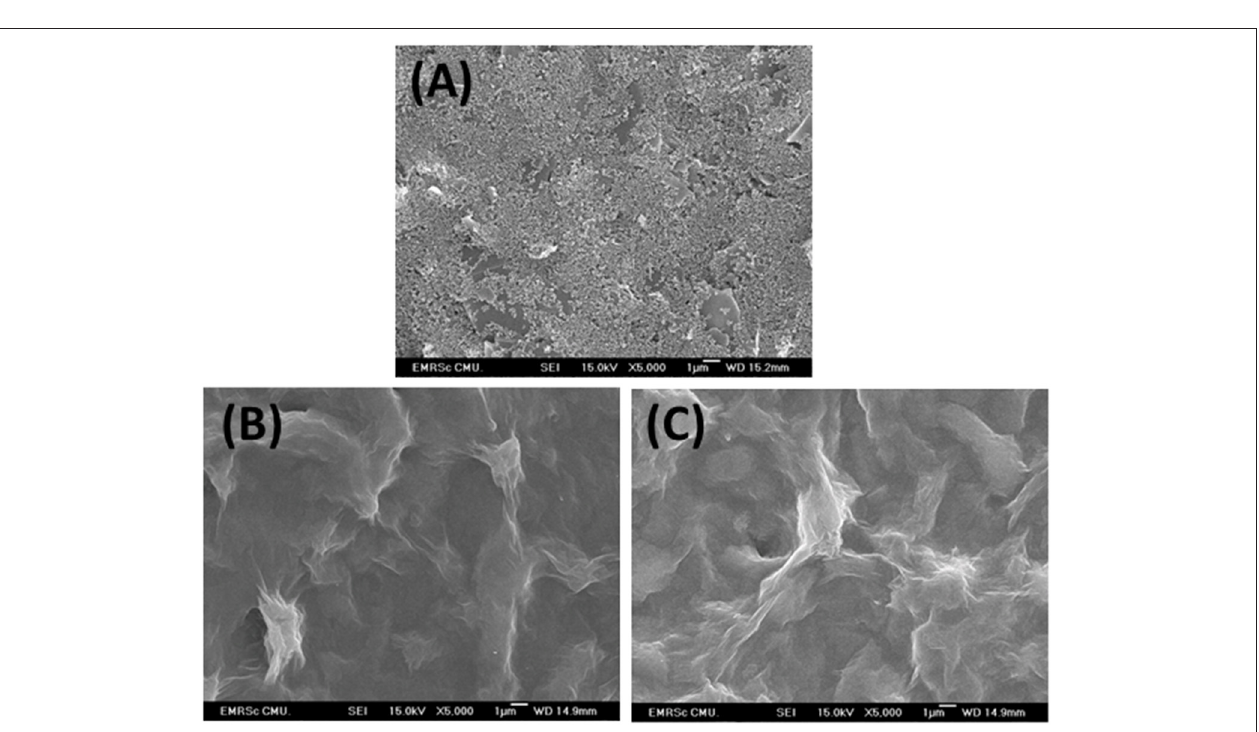
Frontiers in Chemistry |